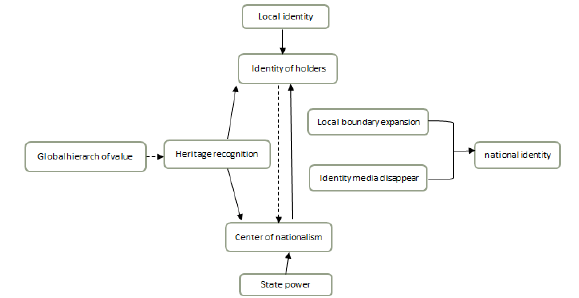
Figure 1 . The impact mechanism framework of heritage recognition and heritage